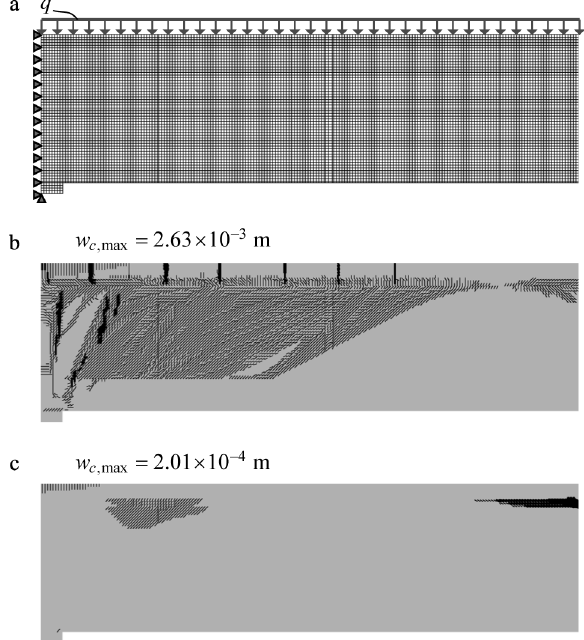
Fig. 8. FEM of the bridge segment (a) and the crack pattern predicted without (b) and with (b) pre-stressing